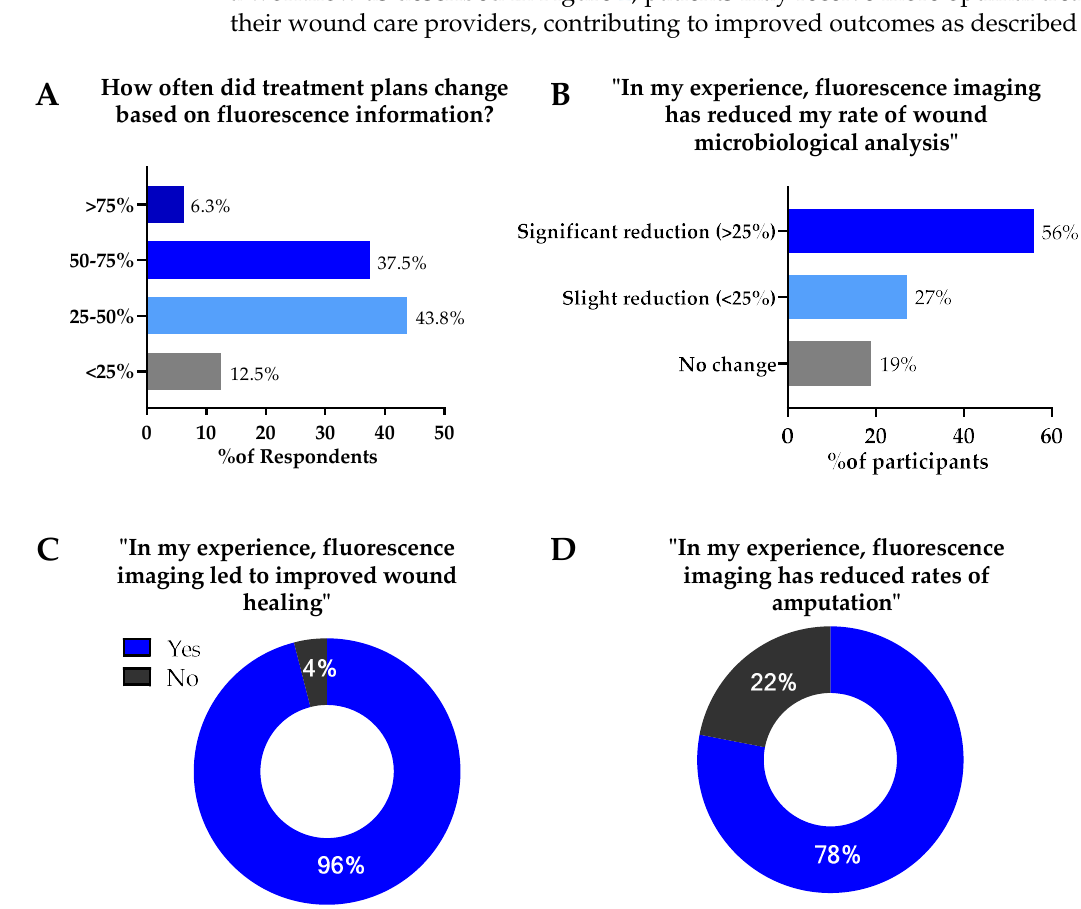
Figure 4. Impact of fluorescence imaging of bacteria on treatment protocols and wound outcomes. A total of 31 participants provided responses. ( A ) Percent of Delphi participants reporting changes in treatment plans based on fluorescence imaging. ( B ) Percent of participants reporting reduction in wound sampling for microbiological analysis because of point—of—care fluorescence imaging information. ( C ) Percent of participants indicating improvements in wound healing due to use of fluorescence imaging. ( D ) Percent of participants indicating reduced rates of amputation due to use of fluorescence imaging.